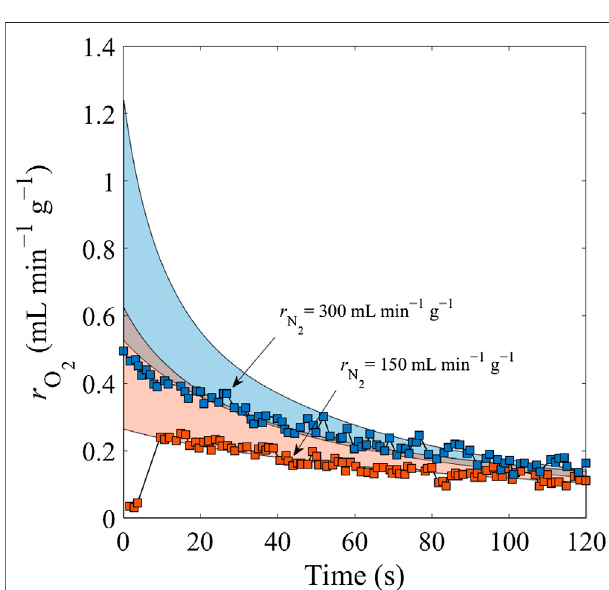
FIGURE 8 | Comparison of predicted (color areas) and measured (squares) data for N 2 sweep gas fl ows of 150 mL min − 1 g − 1 (orange) and 300